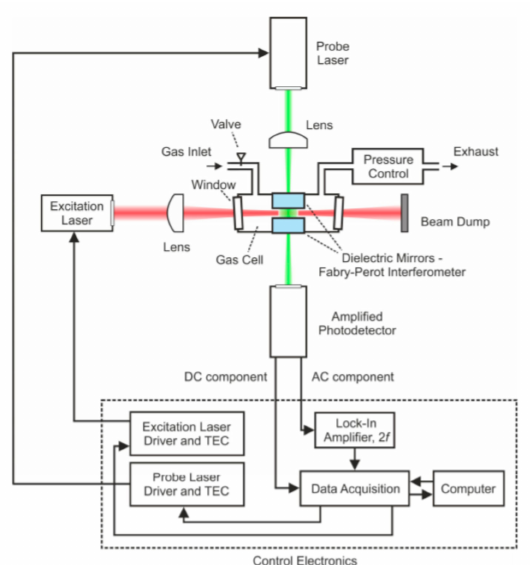
Figure 13. Schematic of the Fabry-Perot interferometer-based photothermal gas sensor. Reprinted with permission from [59] C The Optical